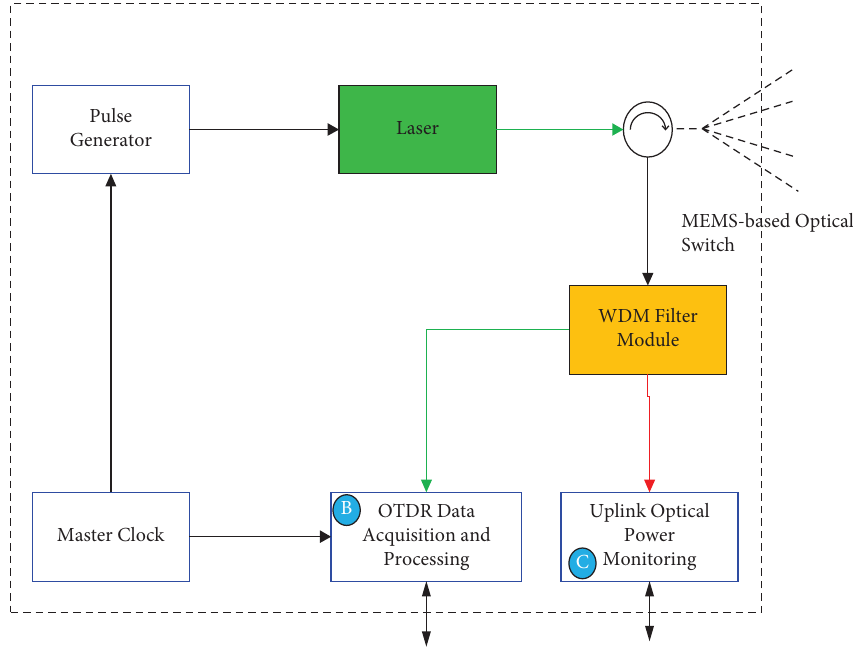
Figure 3: Main components of the equipment A.